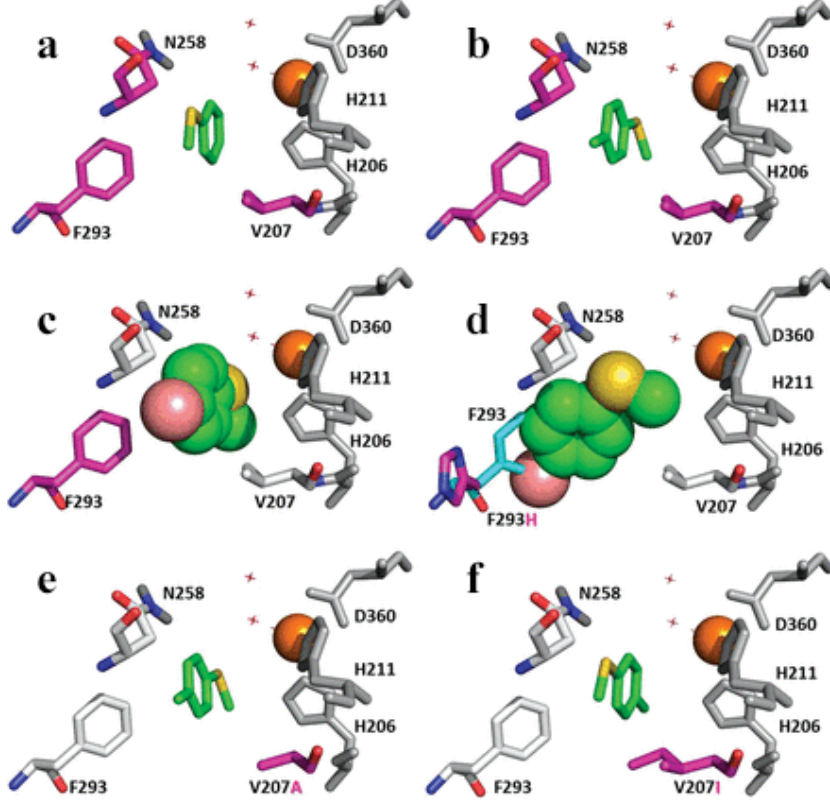
Figure 8 - Molecular models of thioanisole, Br-thioanisole and Me-thioanisole in the active site. The amino acid residues that were subjected to mutagenesis are presented in magenta color (V207, F293 and N258). ( a ) Thioanisole in wild type active site; ( b ) p-tolyl in wild type active site, ( c ) Br-thioanisole in wild-type active site, ( d ) Br-thioanisole in F293H, ( e ) p-tolyl in V207A modified enzyme and ( f ) p-tolyl in V207I modified enzyme. Reprinted with permission from Oxoford University Press. (Shainsky et al. 2013) Copyright 2015 Oxford University